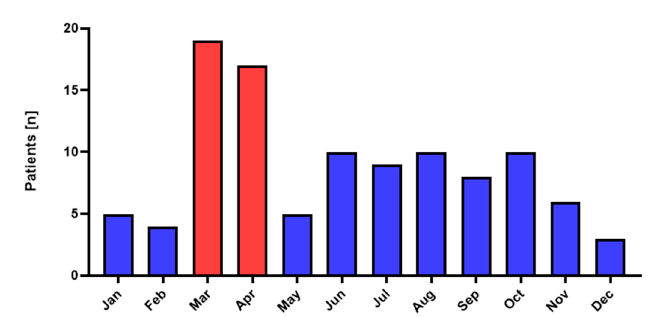
Figure 1. Trauma patients admitted to the Galilee Medical Center in 2019.